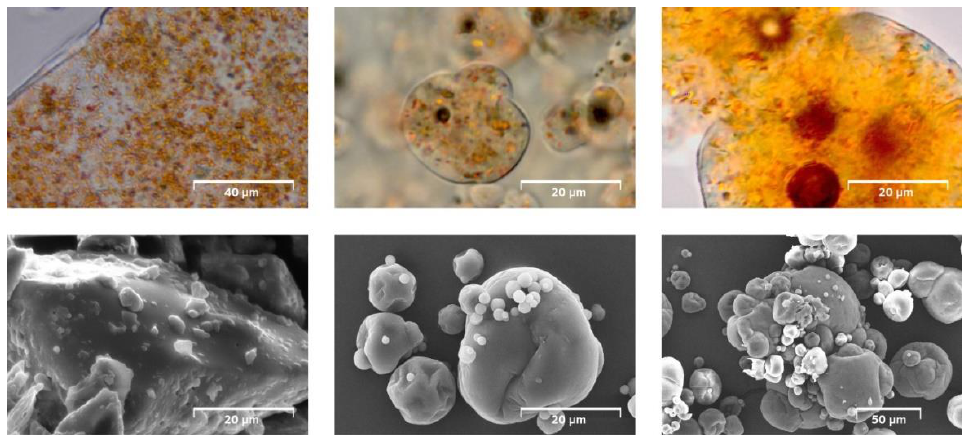
Figure 3. Microscopic images (top: light microcopy, bottom: SEM) of carrot concentrate powders: freeze-dried (FD; left), spray dried reference (SD-Ref; middle), and spray dried powder collected from the drying chamber (SD-E; right).